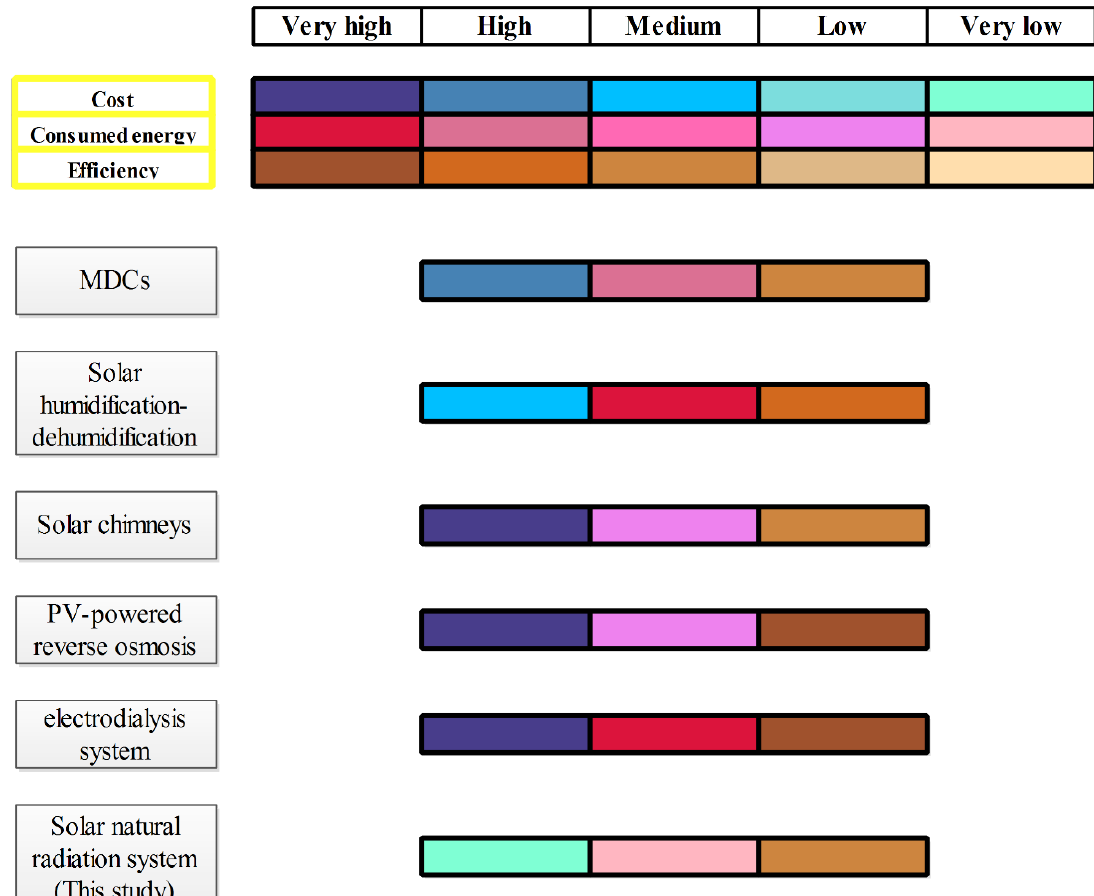
Figure 13. Schematic plan of the different desalination technologies’ advantages and disadvantages [26 – 34].